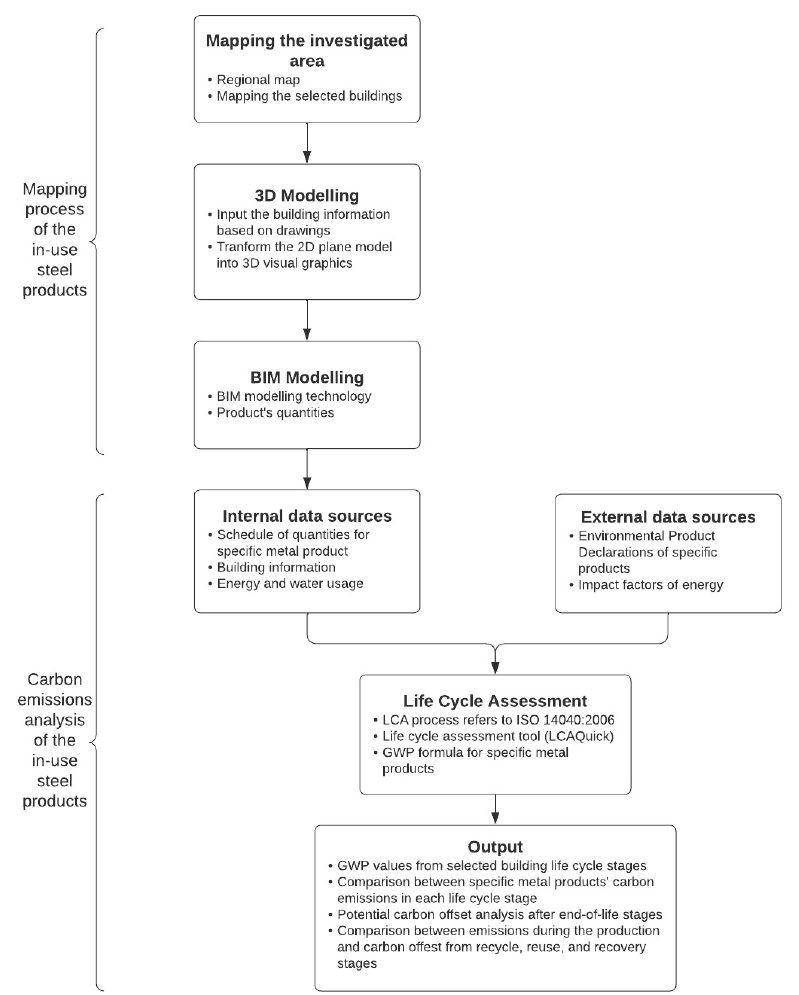
Figure 1. Overall modelling and workflow of the study.